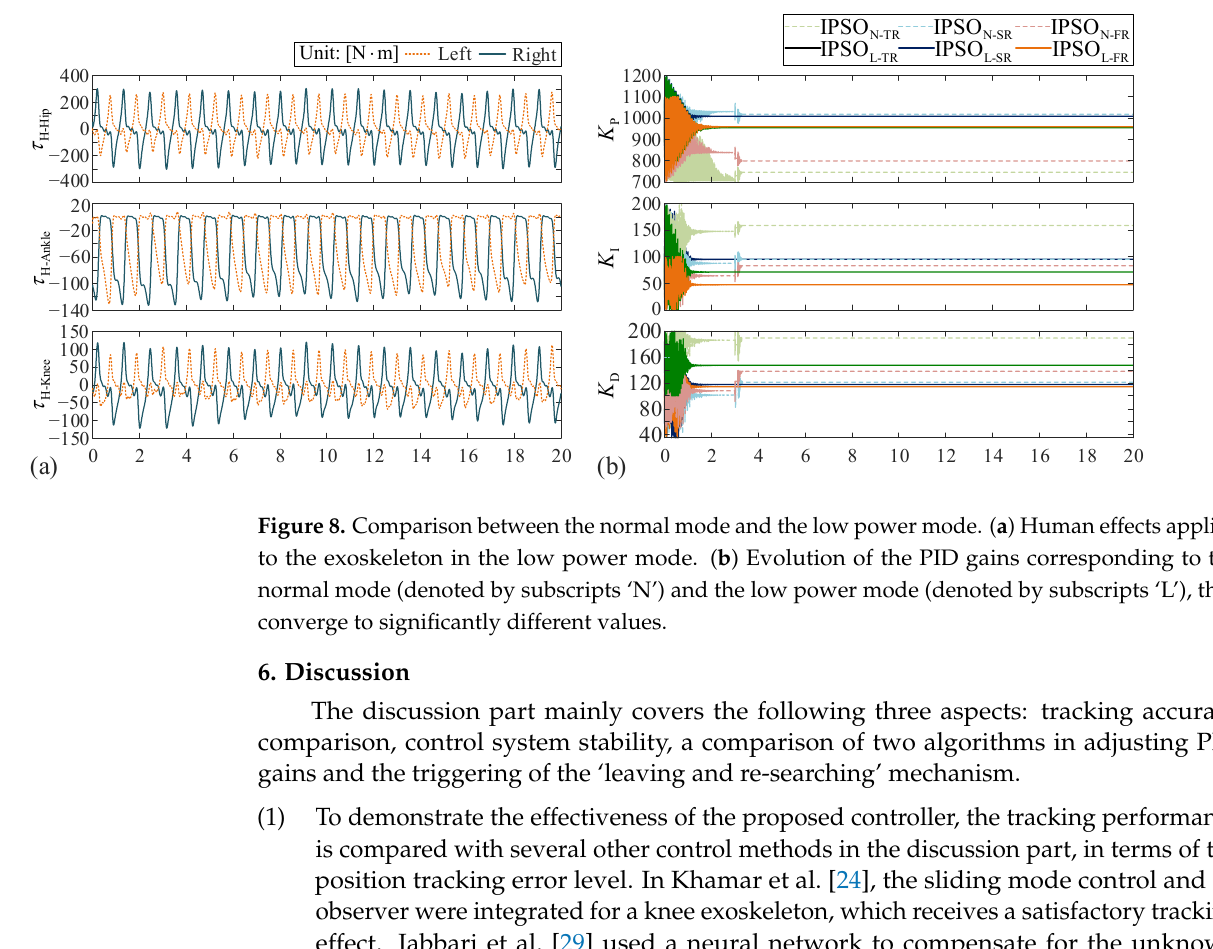
(20) Table 1. Tracking accuracy of different methods. Articles